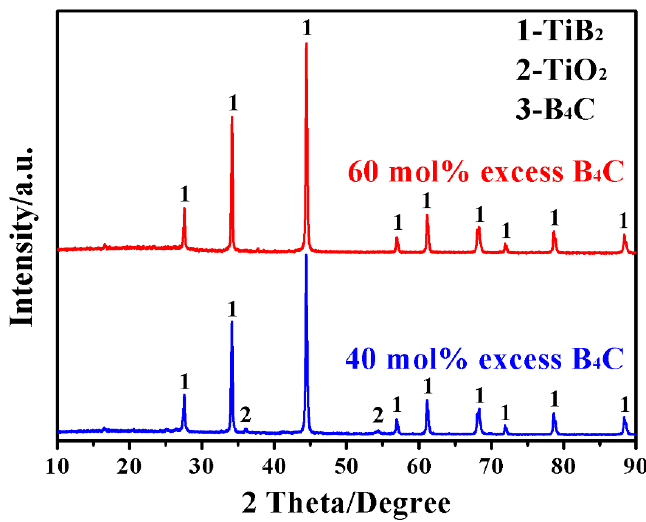
Figure 4. XRD patterns of samples containing initially 40 and 60 mol% excessive B 4 C, after MSM-BCTR treatments at 1200 °C for 20 min.